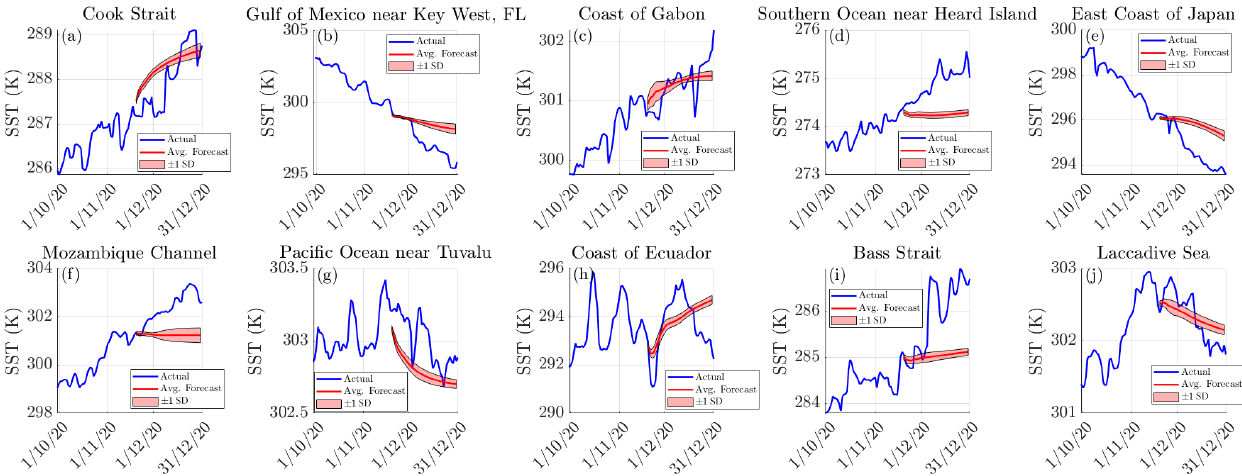
Figure 7. Forecasted SSTs at various points in the ocean with the model running autonomously. The average forecasted SSTs and the actual SSTs are represented by the red and blue lines, respectively, with the shaded outline surrounding the average forecasted SSTs representing ± 1 standard deviation in the forecast between the